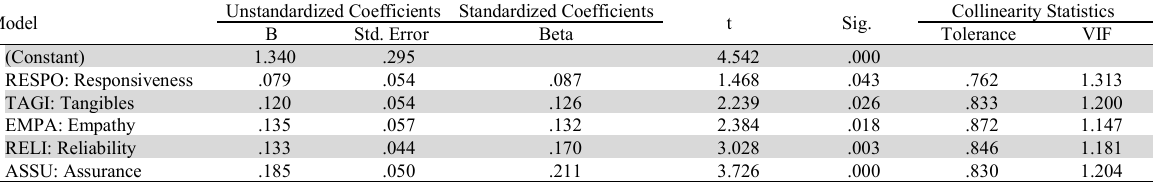
Regression analysis results of Perceived Value Model